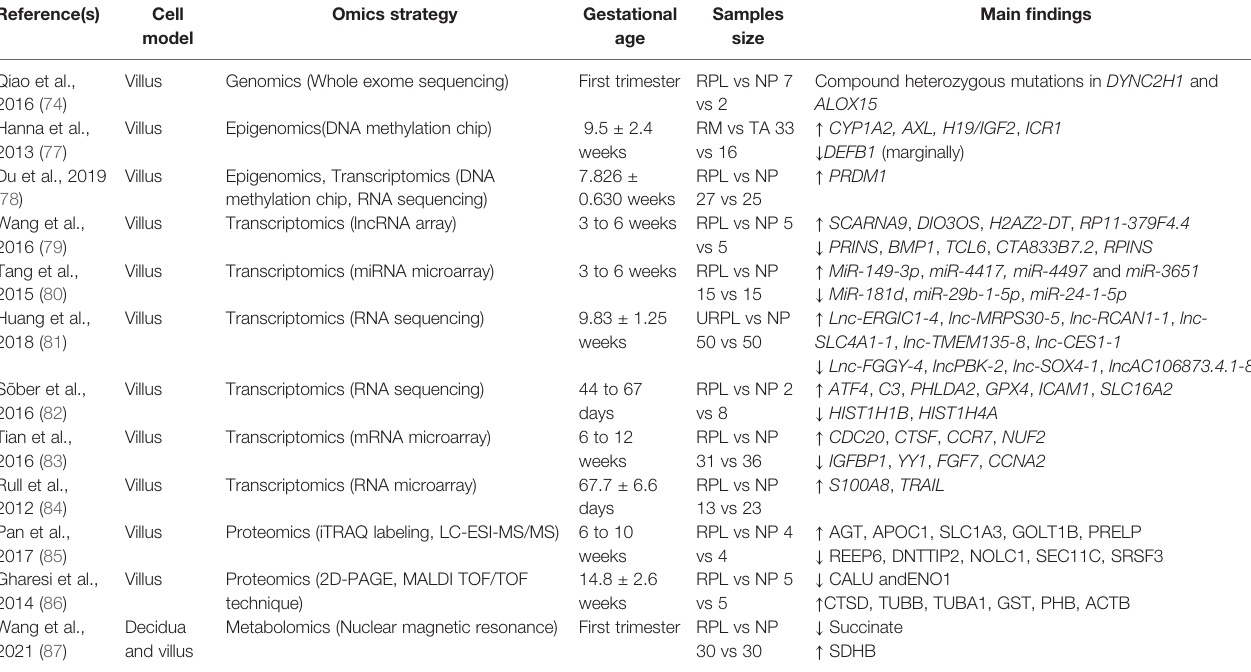
TABLE 2 | Omics studies on villous tissue of recurrent pregnancy loss patients and controls. Reference(s)